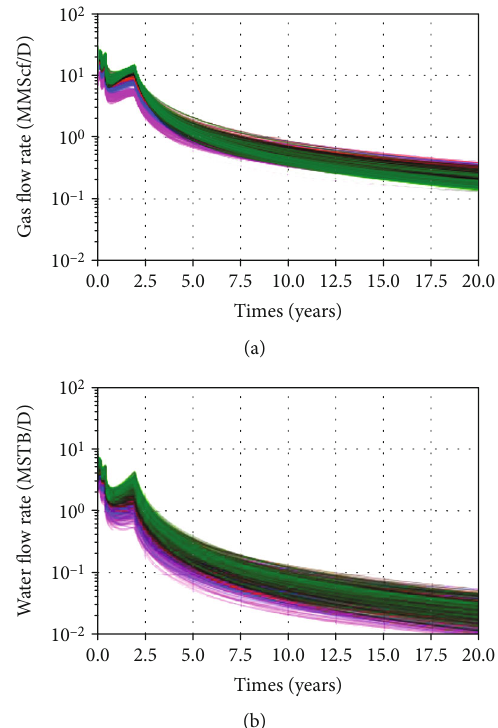
Figure 8: Gas and water fl ow rates for di ff erent well scenarios: (a) gas fl ow rate and (b) water fl ow rate (MMscf represents million standard cubic feet while MSTB is thousand standard barrels).